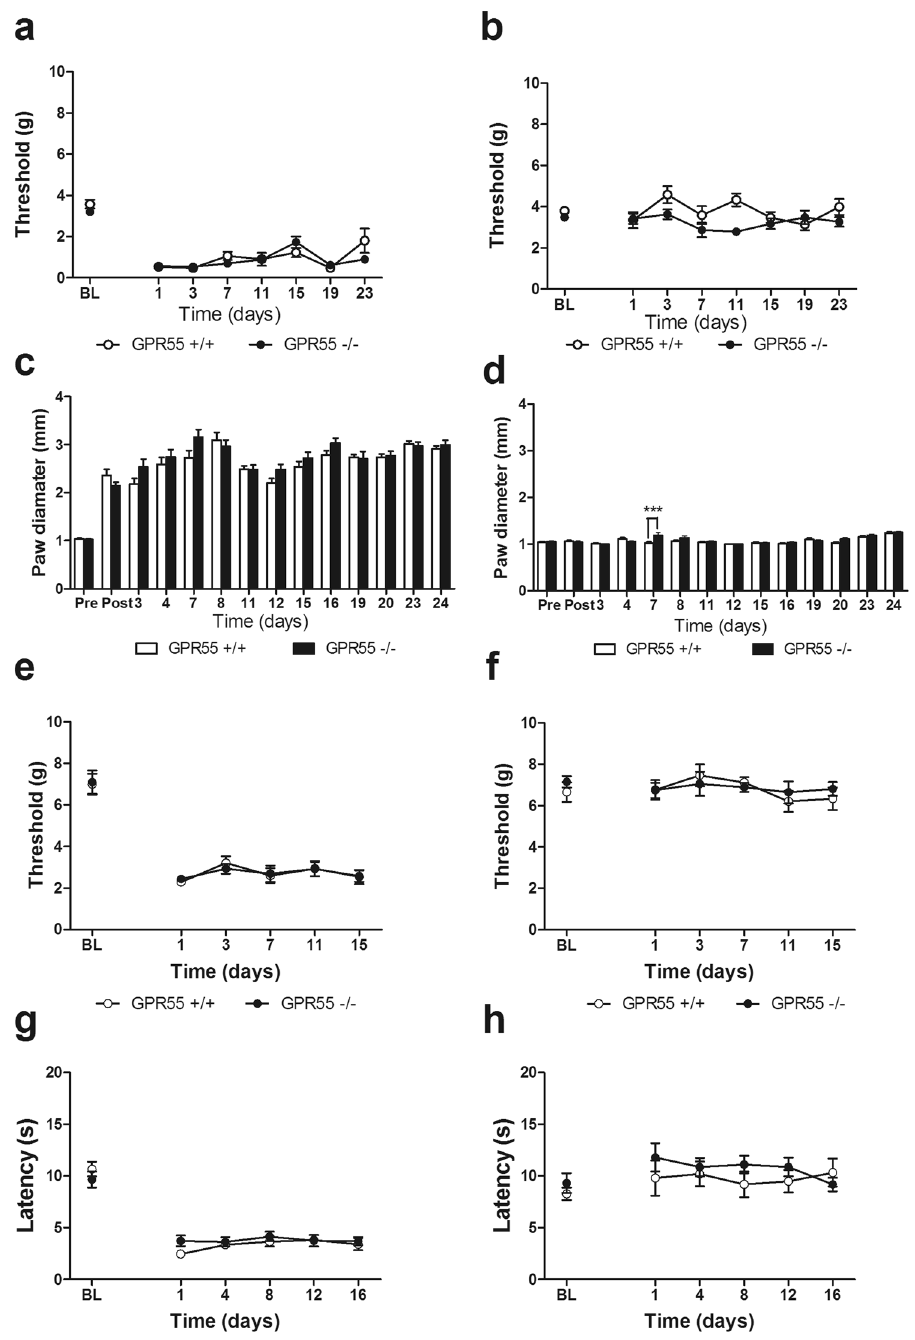
Figure 5. CFA elicits comparable levels of mechanical and thermal hypersensitivity in GPR55 KO and WT mice. Levels of CFA-evoked mechanical hypersensitivity do not differ between GPR55 KO and WT mice ( a ). CFA does not elicit mechanical hypersensitivity in the paw contralateral to CFA administration ( b ). Paw diameters were similar in the CFA-injected (ipsilateral) paw in GPR55 KO and WT mice ( c ). Paw diameters were elevated in GPR55 KO relative to WT mice in the paw contralateral to CFA administration on day 7 only ( d ). Data are expressed as mean ± SEM (n = 8–9 per group). *** p < 0.001 vs. WT, 2-way ANOVA, Bonferroni post-hoc. In an independent replication, GPR55 KO and WT mice develop similar levels of mechanical ( e ), and thermal hypersensitivity ( g ) following i.pl. CFA. Mechanical ( f ), and thermal ( h ) hyperalgesia do not develop in the paw contralateral to CFA administration. Data are expressed as mean ± SEM (n = 8 per group). 2-way